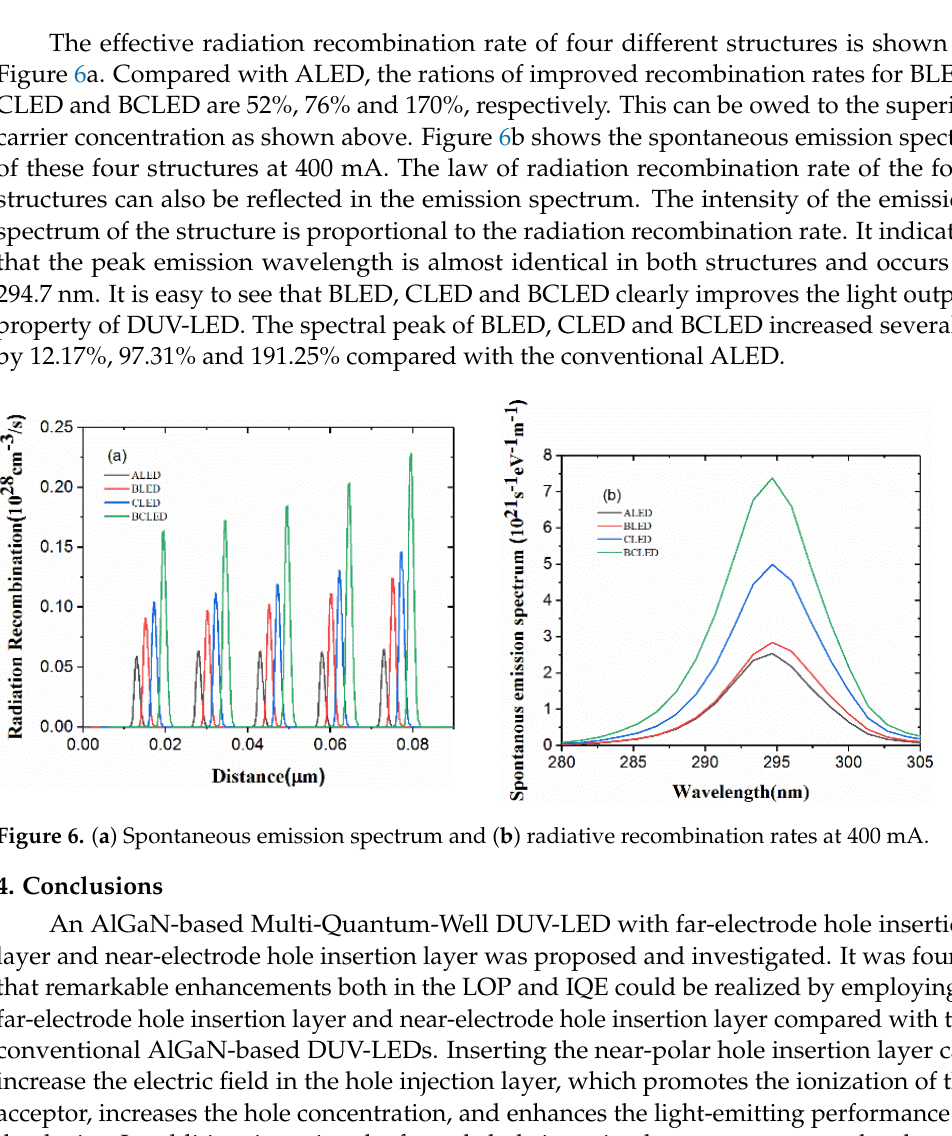
Figure 5. ( a ) Electron concentrations and ( b ) hole concentrations of the four structures at 400 mA.